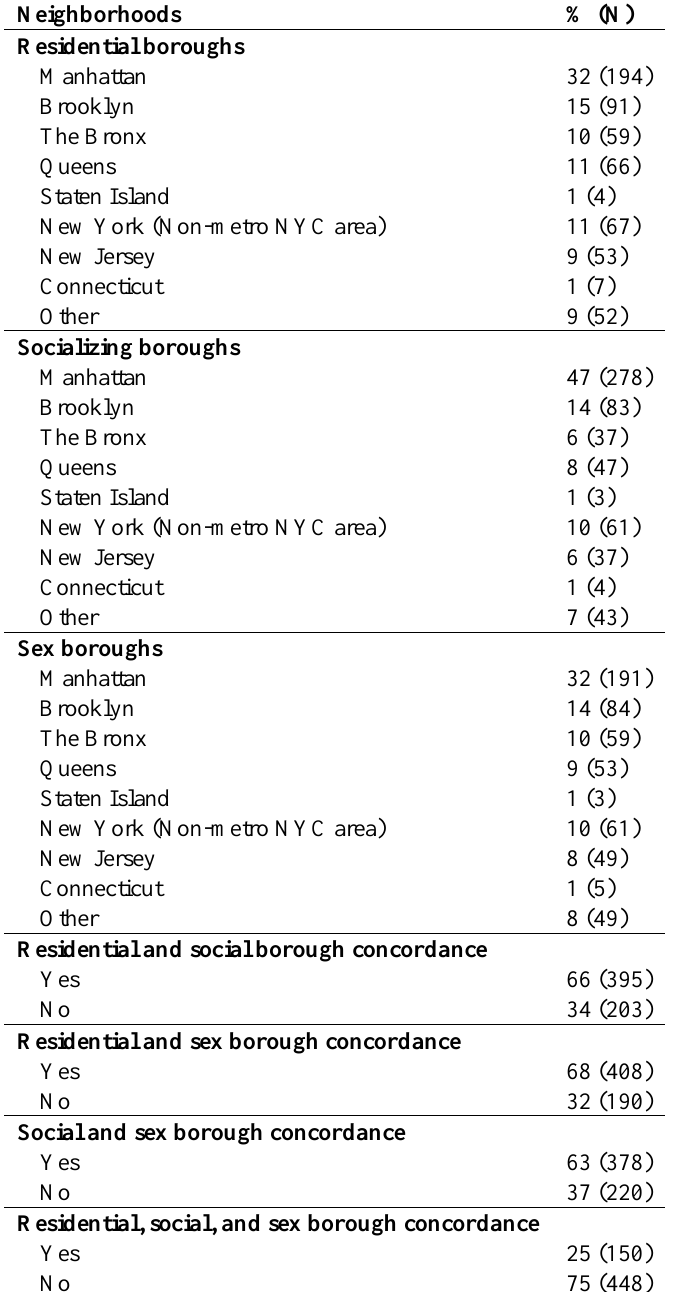
Table 1. Distribution of self-reported residential, social and sex neighborhoods (boroughs) among YMSM in the Project 18 study,